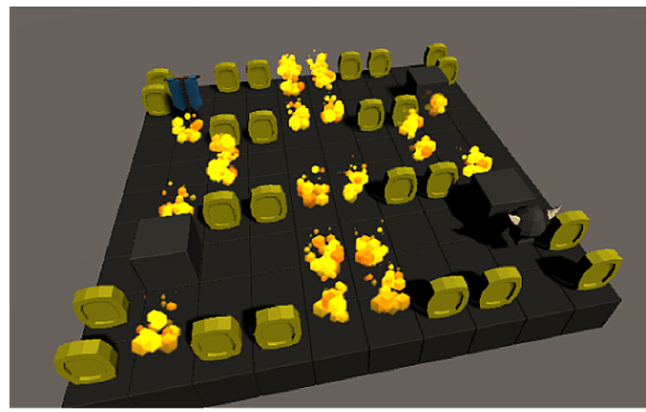
Figure 11. Small room inside the scene.